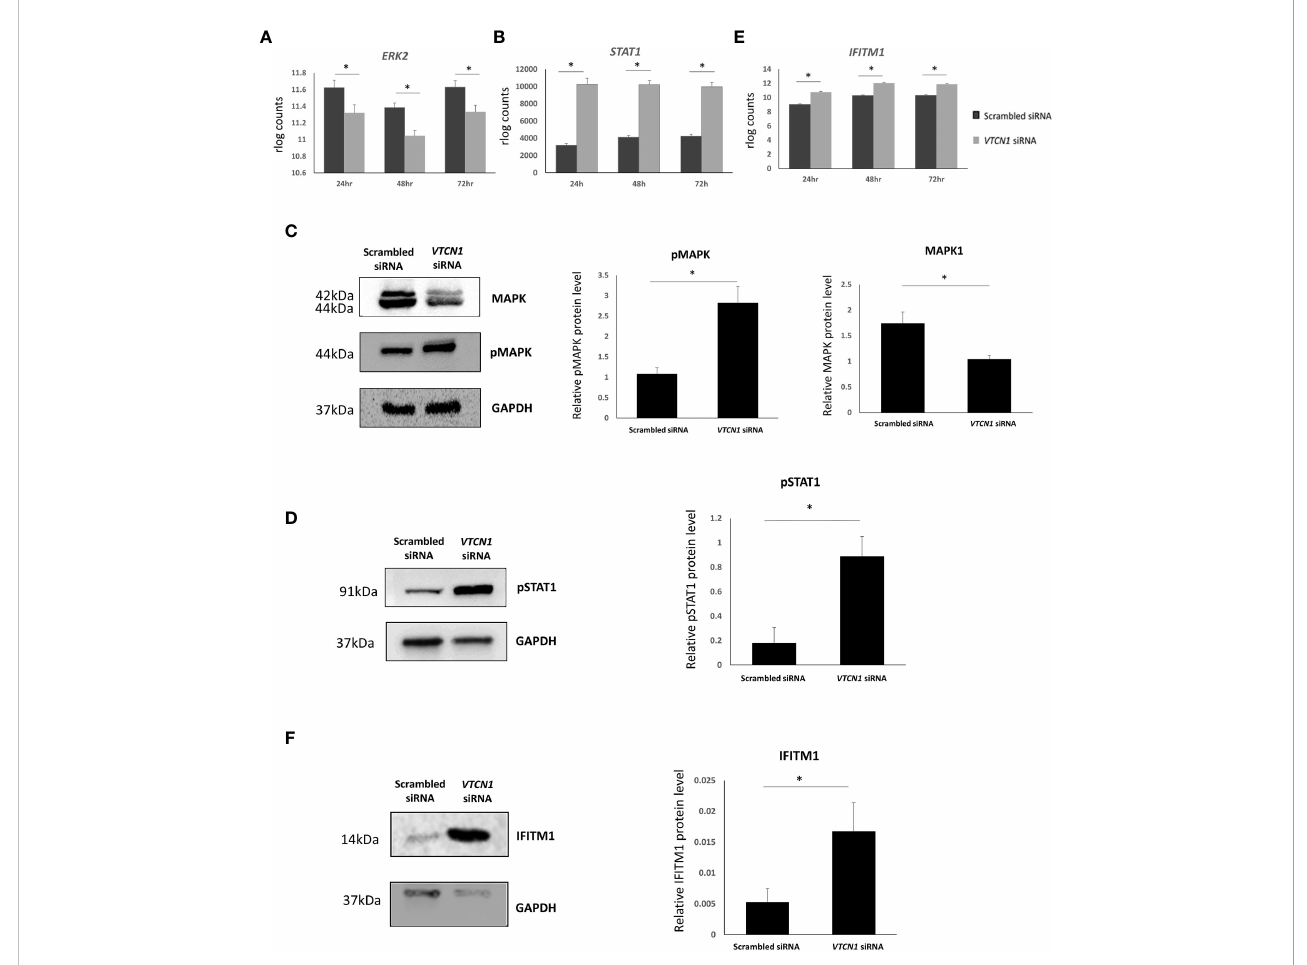
FIGURE 4 Transcript expression levels (in rlog counts) for ERK2 (A) , STAT1 (B) , and IFITM1 (E) in BAP differentiated TB cells exposed to scrambled siRNA or VTCN1 siRNA for 24h, 48h and 72h (BAP d4, d5 and d6). The hESCs were passaged and transfected as explained in the legend of Figure 1. Benjamini – Hochberg P value adjustment method were done with DESeq2. An adjusted p value less than 0.01 was considered to be statistically signi fi cant. Protein levels of MAPK and pMAPK (C) ; pSTAT1 (D) ; and IFITM (F) in BAP differentiated TB cells on d6 (3 days after transfection) were assessed by western blotting. Three independent western blots were quanti fi ed by densitometry using ImageJ Software. The protein expression of MAPK, pMAPK, pSTAT1 and IFITM1 was normalized to the corresponding GAPDH signals of appropriate samples. Pairwise comparisons were determined using the Student ’ s t test, with a signi fi cance of p < 0.05 indicated by